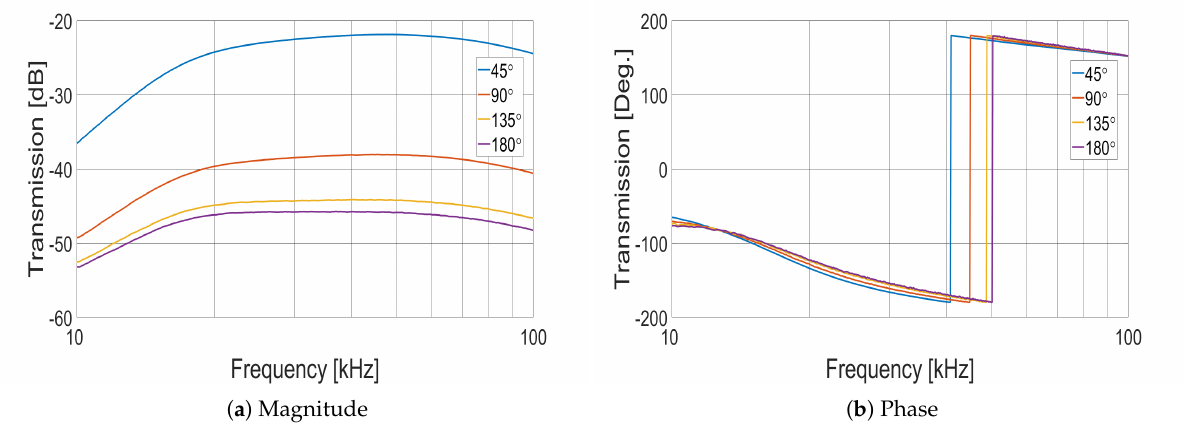
Figure 2. Coil pair transmission measurements (S 21 ), for the four different angular displacements.